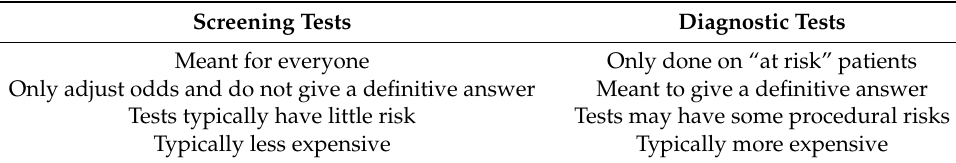
Table 1. Diagnostic vs. screening tests.